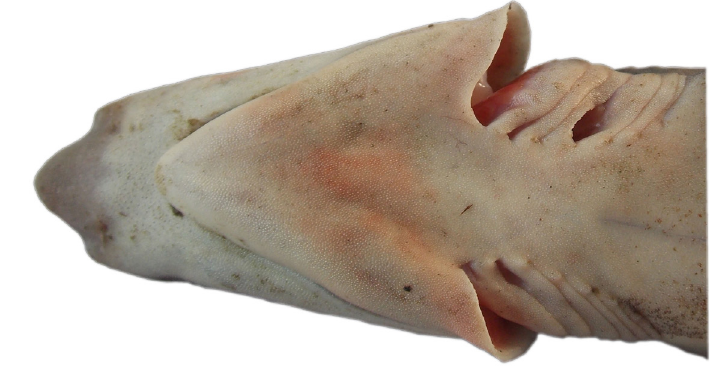
Fig. 3. Ventral view of the head region showing seven pairs of gill openings of Heptranchias perlo